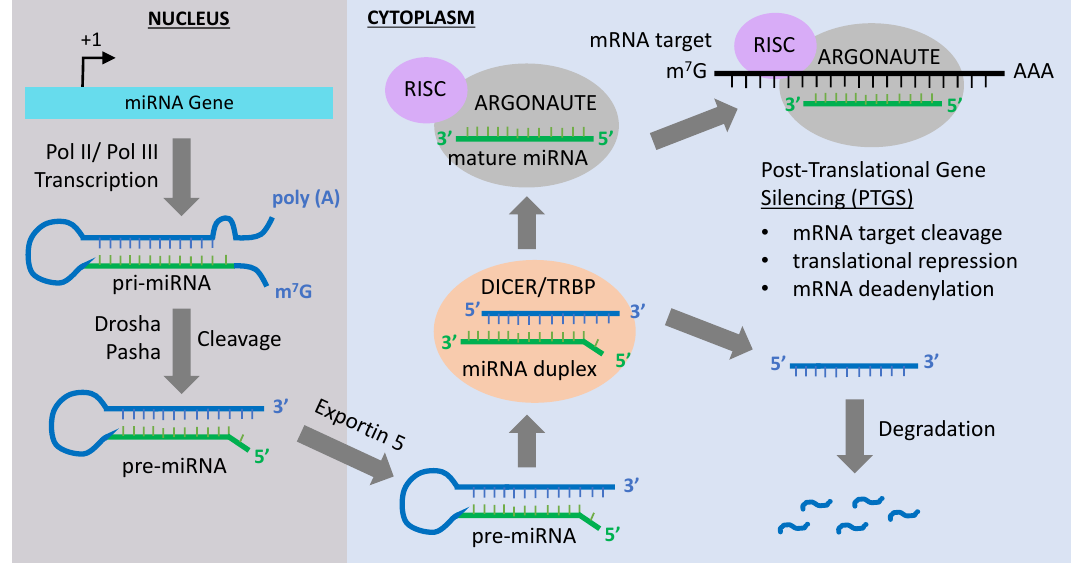
Figure 1. MicroRNA (MiRNA) biogenesis pathway. Transcription of the miRNA gene by RNA polymerase Pol II or Pol III produces a primary transcript (priRNA) that is cleaved by the ribonuclease III Drosha and processed by the double-stranded RNA-binding protein Pasha in the nucleus. This results in the formation of a precursor miRNA (pre-miRNA) hairpin, which is exported from the nucleus via exportin-5-mediated translocation. Once in the cytoplasm, the pre-miRNA is cleaved by the RNase DICER in a complex with the double-stranded RNA-binding protein TRBP to generate a miRNA duplex. The non-functional strand of the miRNA duplex is subjected to degradation, while the mature miRNA (functional strand) binds to ARGONAUTE proteins and the RNA-induced silencing complex (RISC). The mature miRNA guides RISC to silence mRNA targets by cleavage, translational repression or